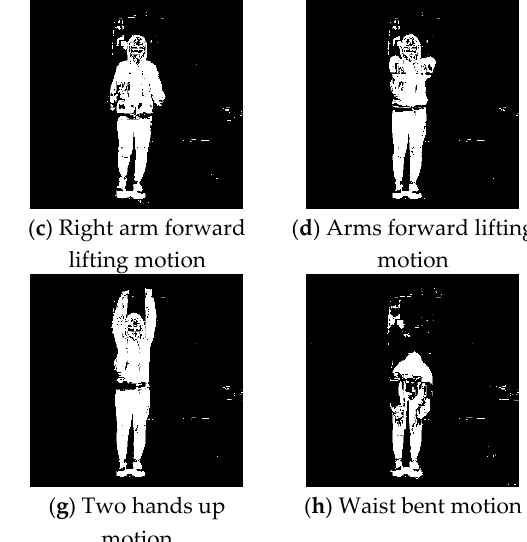
( h ) Waist bent motion Figure 11. Depth images generated by up-sampling 3D point clouds-based depth images bilateral filtering. The numbers of additional pixels characterized in the proposed method and the bilateral filtering method are compared in Figure 12. The 3D point cloud-based depth image provided an average of 3342.6771 pixels, and the proposed depth image provided an average of 7687.2071 pixels. In the depth image generated with bilateral filtering, an average of 5713.6205 pixels were provided. The depth images from the proposed method provided 4,991,865 more pixels than were present in